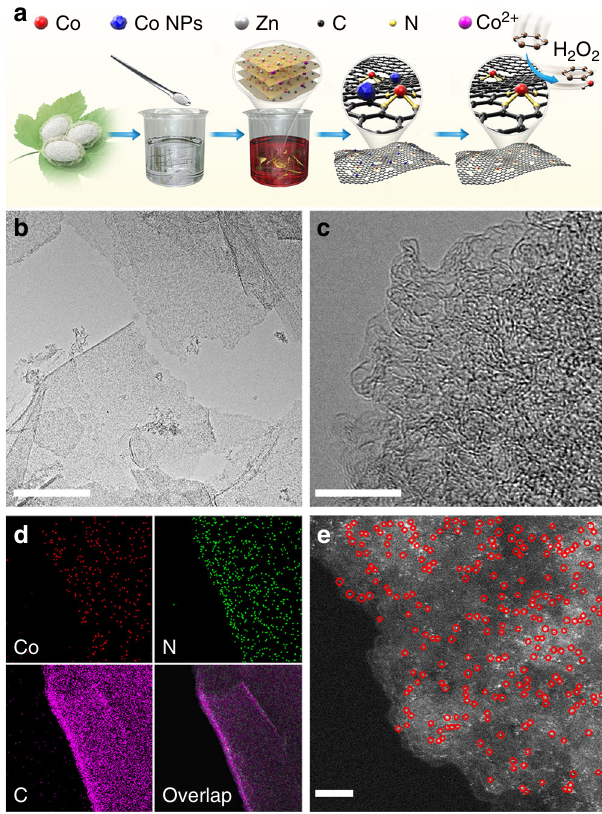
Fig. 1 Synthesis and characterizations of Co-ISA/CNS catalyst. a Illustration of the proposed formation mechanisms. b TEM image. Scale bar, 500 nm. corrected HAADF-STEM image. Scale bar, 2